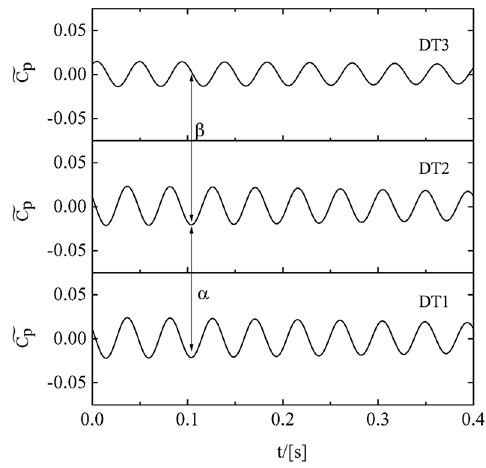
Figure 7. Band-pass-filtered pressure fluctuations at OP3.